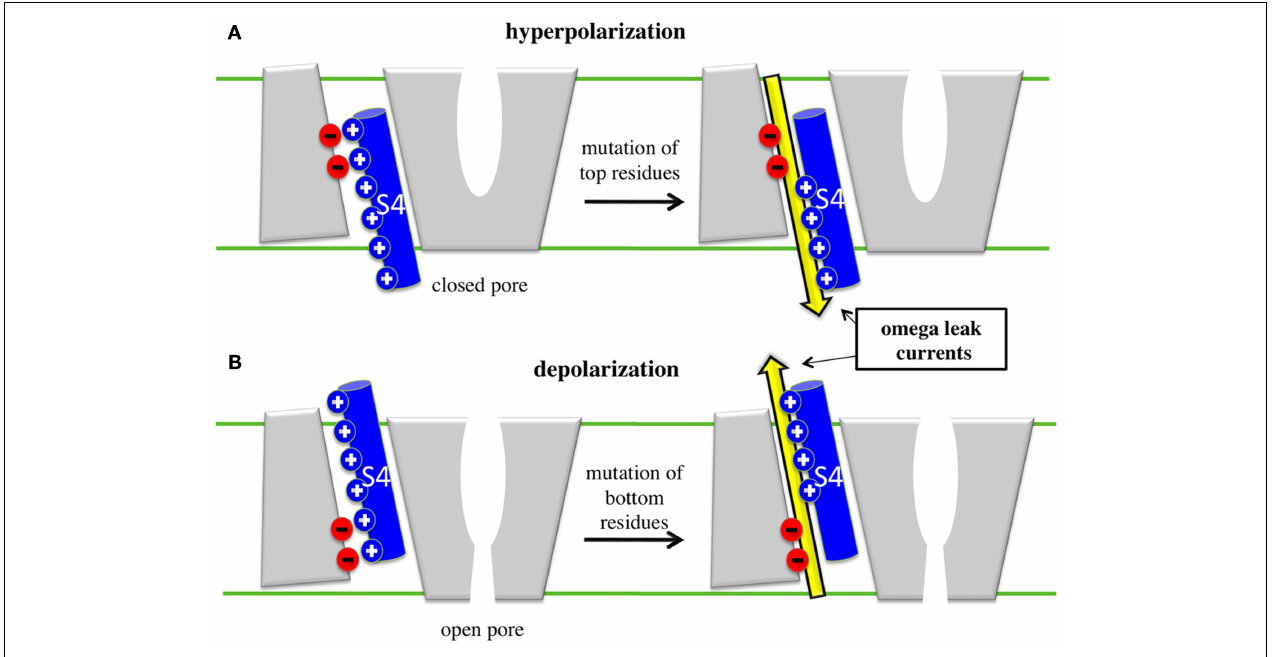
an inward cation leak (yellow arrow). (B) Under depolarized potentials, when theVSD is activated, mutation of bottom residues gives rise to outward omega